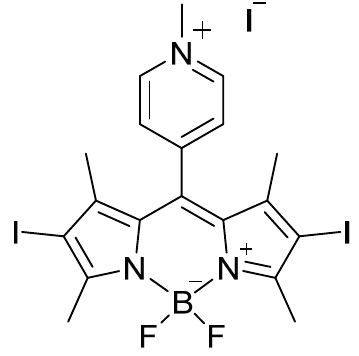
Figure 1. The DIMPy-BODIPY photosensitizer employed in this